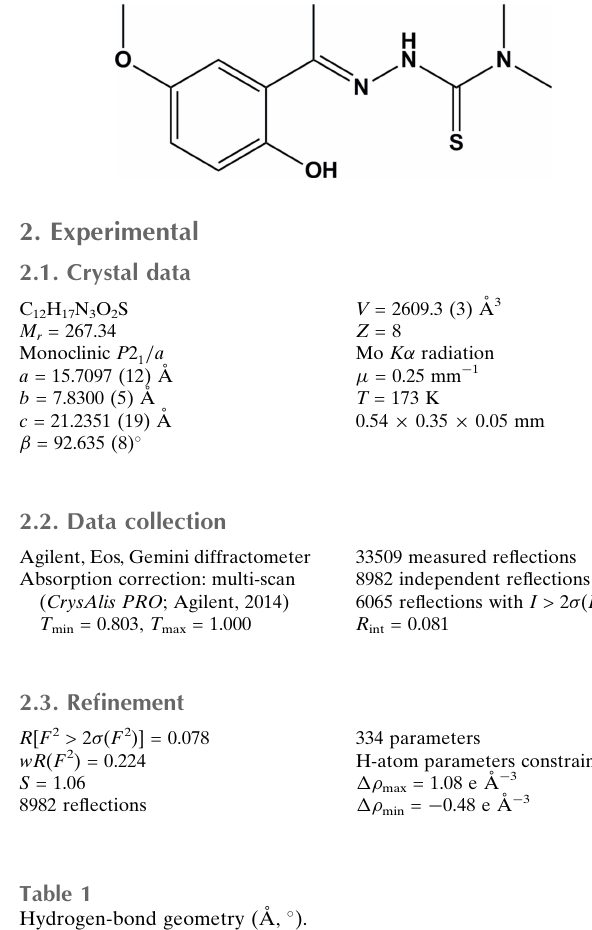
Hydrogen-bond geometry (A˚ , (cid:2)